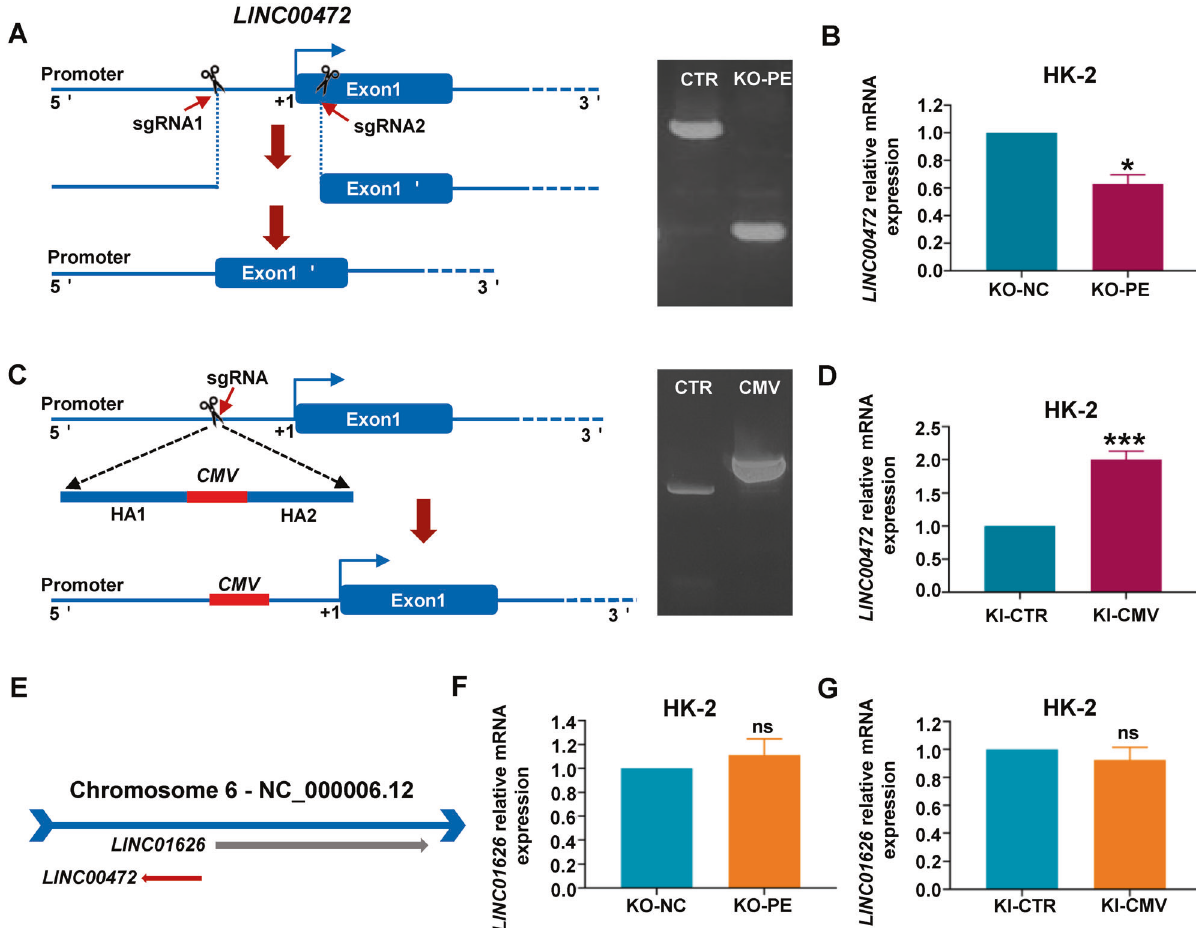
Fig. 4 CRISPR-Cas9 was used to construct LINC00472 stable knockdown and overexpression cell lines. A Display diagram of knockdown shear site design. A pair of sgRNAs were designed upstream and downstream of the transcription starting site of LINC00472 gene (Left). DNA agarose electrophoresis showed successful cleavage (Right). B RT-qPCR was used to detect the inhibition ef fi ciency of LINC00472 knockdown cell lines. C Display diagram of CMV knock-in design. sgRNA was designed in the promoter region of LINC00472, 1 kb homologous arm sequences upstream and downstream of the shear site were added on two sides of the CMV sequence (Left). DNA agarose electrophoresis showed the CMV sequence was successful inserted (Right). D The expression level of LINC00472 was detected by RT-qPCR after inserting CMV sequence. E Location diagram of LINC00472 and its adjacent gene LINC01626. RT-qPCR was used to detect the expression of adjacent gene LINC01626 after knockdown ( F ) or overexpression ( G ) of LINC00472 by CRISPR-Cas9. In B , D , F , and G , data were shown as mean ± SD of